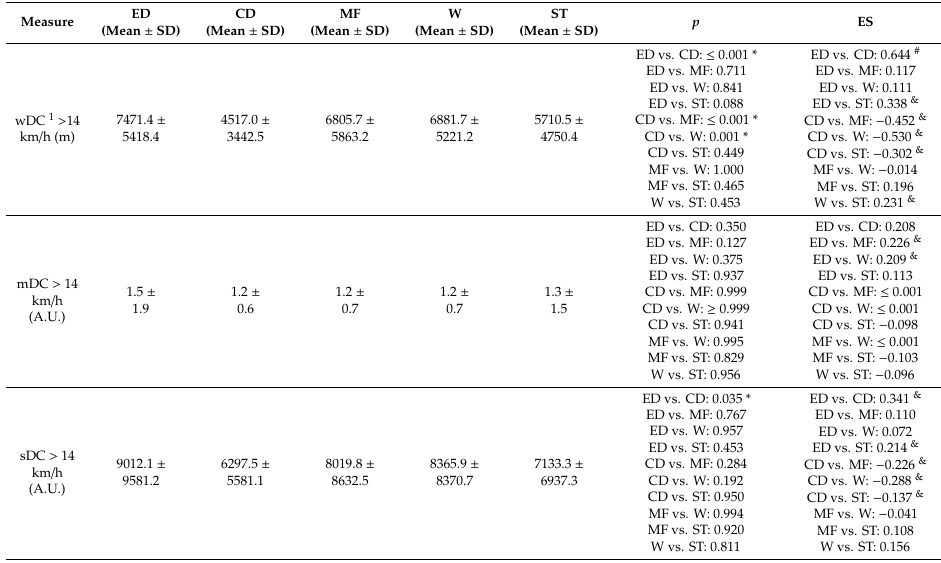
Table 4. Descriptive statistics (mean ± SD) of acute load, training monotony, and training strain for the DC > 14km / h between playing positions.